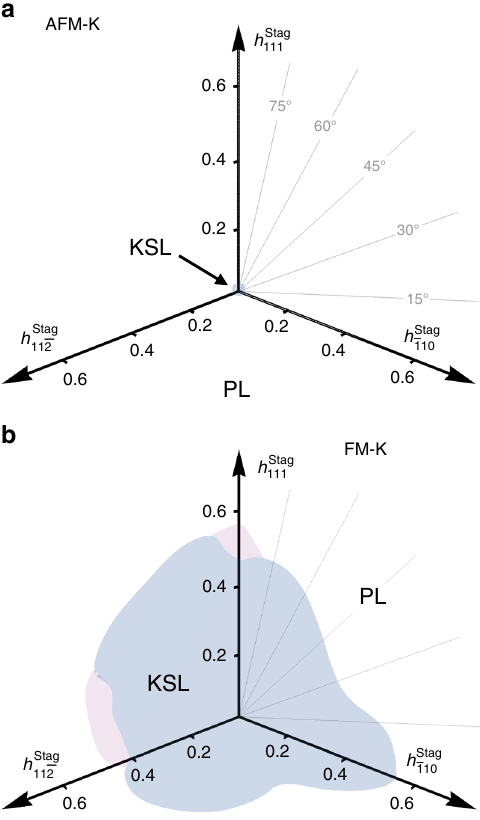
Fig. 2 Phase diagrams in a staggered magnetic fi eld. a The pure AFM Kitaev model and b the pure FM Kitaev model. The pink shading marks a region of potential interest (not explored